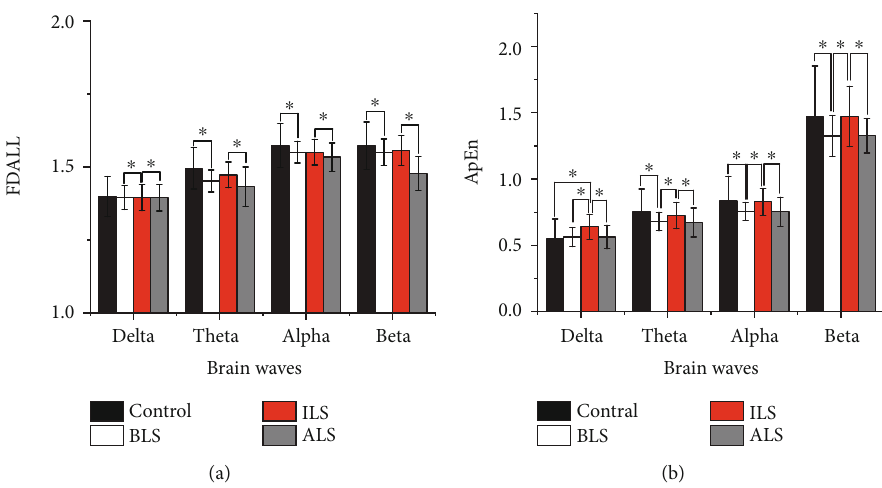
Figure 8: The characteristic value of the LFP signal in the rat striatum brain area after optogenetic experiment. (a) Fractal dimension and (b) approximate entropy. Control represents the LFP signal of rats in the control group; BLS represents the LFP signal before light stimulation in rotenone-treated rats; ILS represents the LFP signal during light stimulation in rotenone-treated rats; ALS represents light in rotenone-treated rat LFP signal after stimulation.